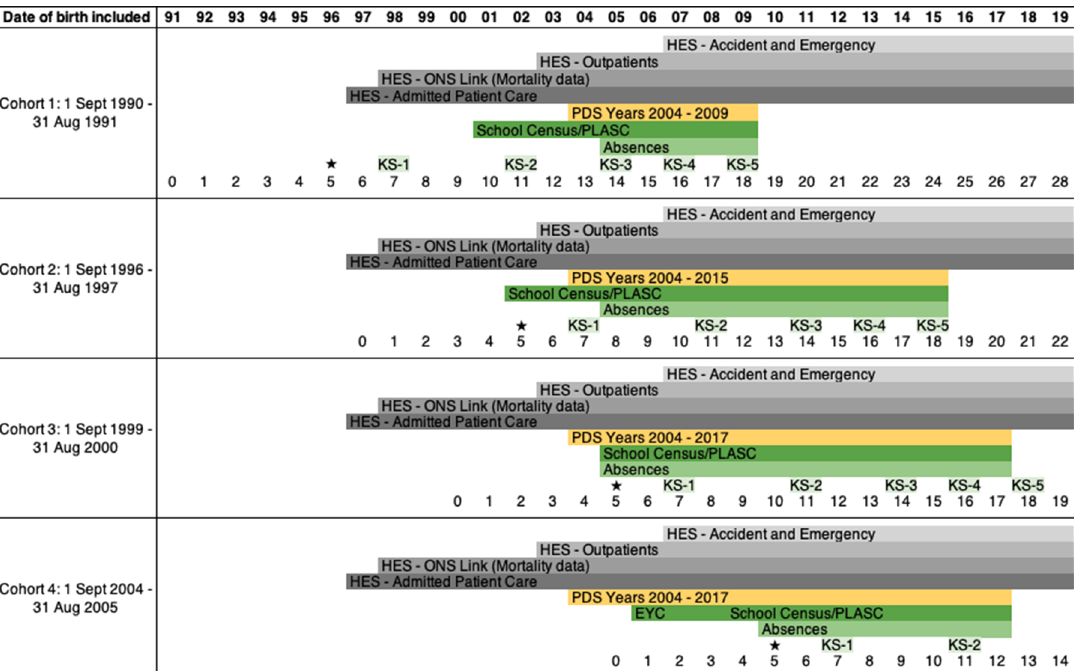
Supplementary Figure S1: Timelines of the four cohorts alongside availability of data from HES (Grey), DfE NPD data (Green) and PDS